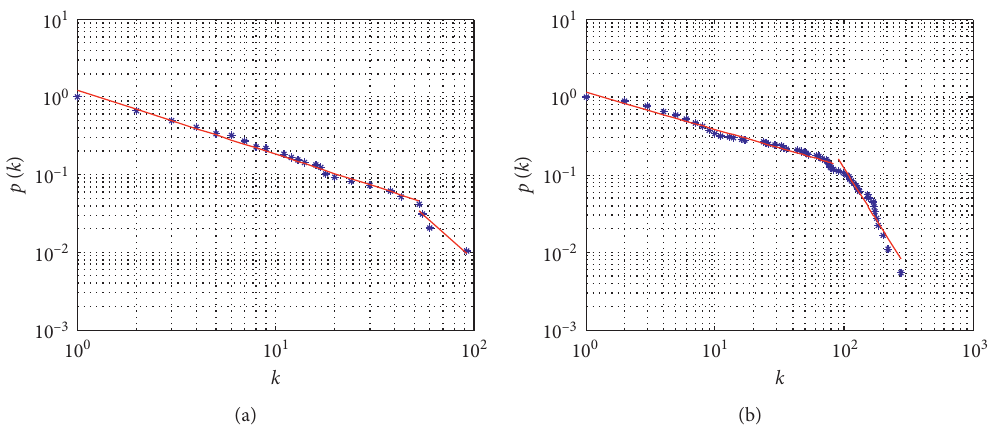
Figure 12: Scaling relations between k and p ( k ) at different time periods. (a) 00: 00–07:00 and (b) 12:00–19: 00.